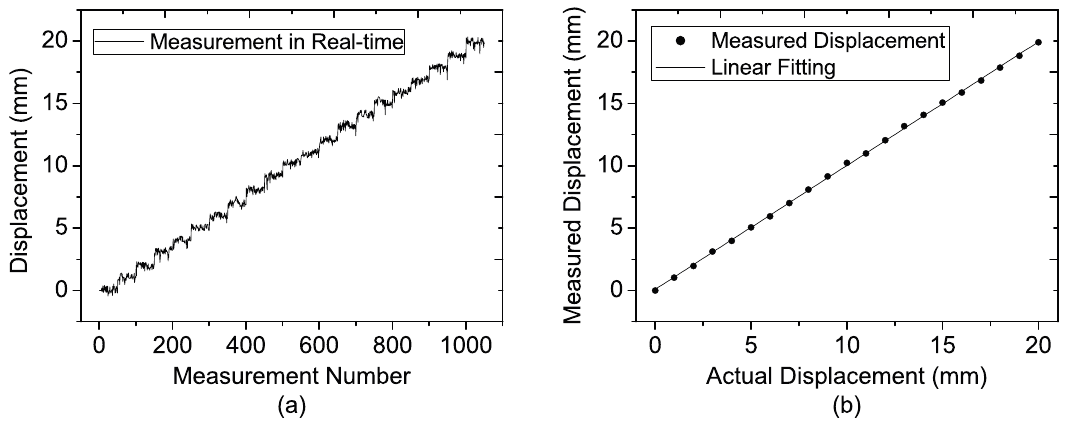
Figure 15. Measured results of the target located at the distance of 50 m at each step for ( a ) 50 single-measurement results; ( b ) Average of the 50 single-measurement results.